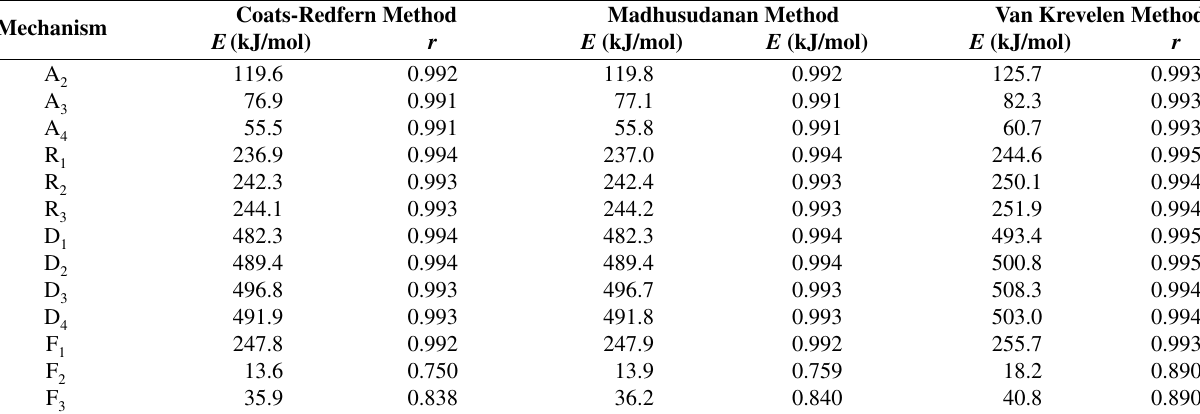
Table 4. Activation energies obtained for several solid state processes at a heating rate of 15 °C/min Coats-Redfern